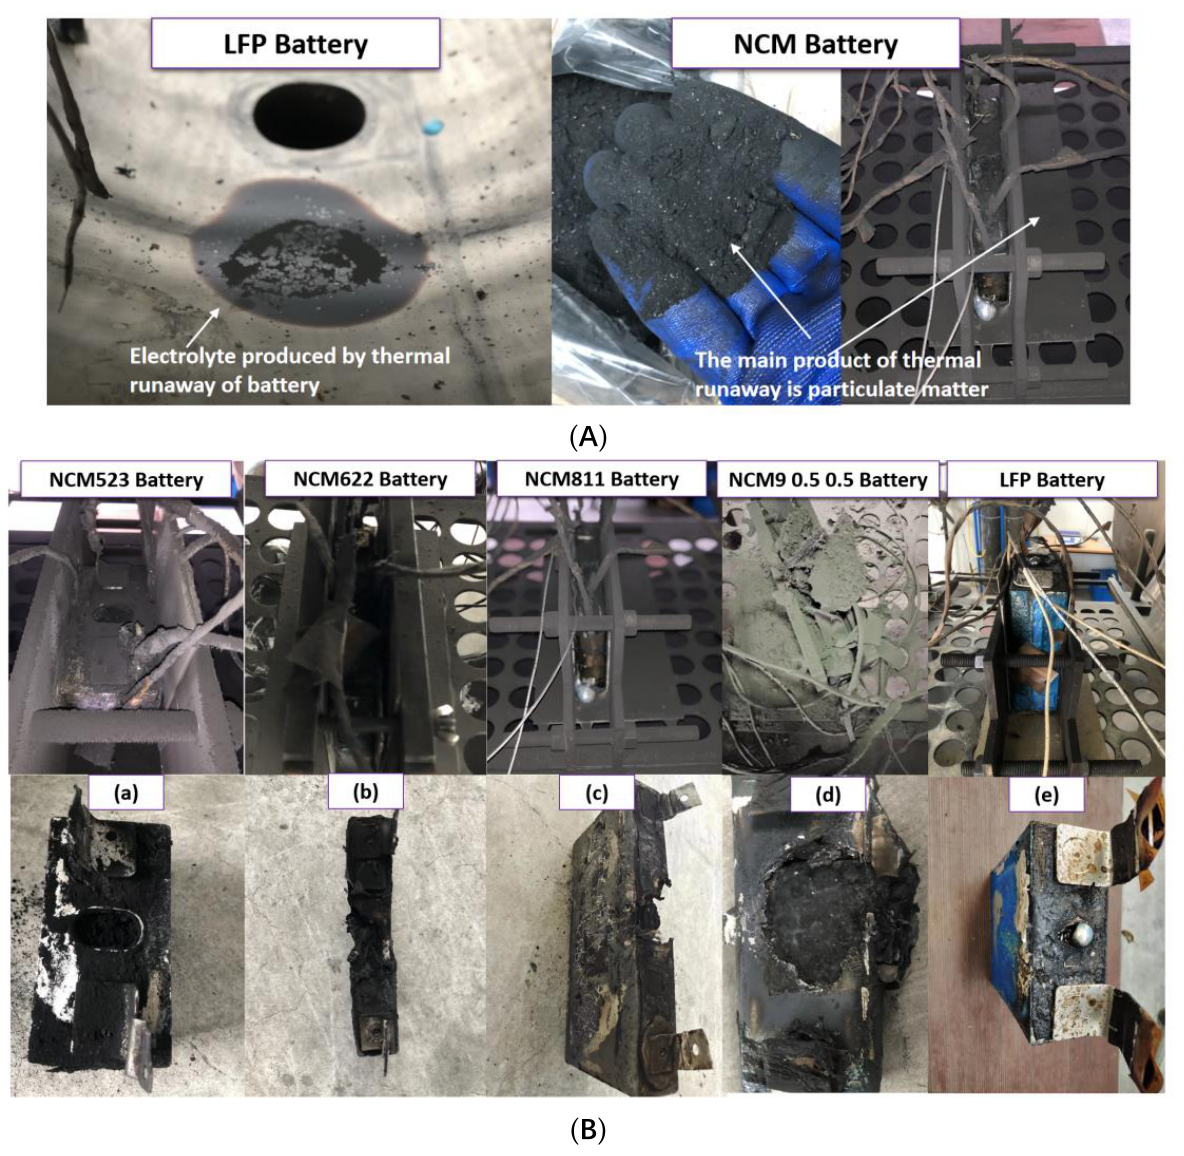
Figure 12. ( A ) Comparison of main products after TR of battery. ( B ) Subfigures ( a – e ) correspond to the photographs of NCM523, NCM622, NCM811, NCM, and LFP batteries, respectively, taken after the experiments.